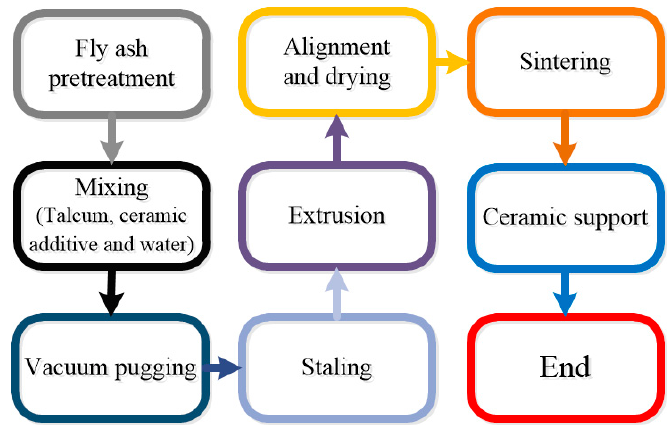
Figure 1. Fly ash-based ceramic membrane supports preparation process.